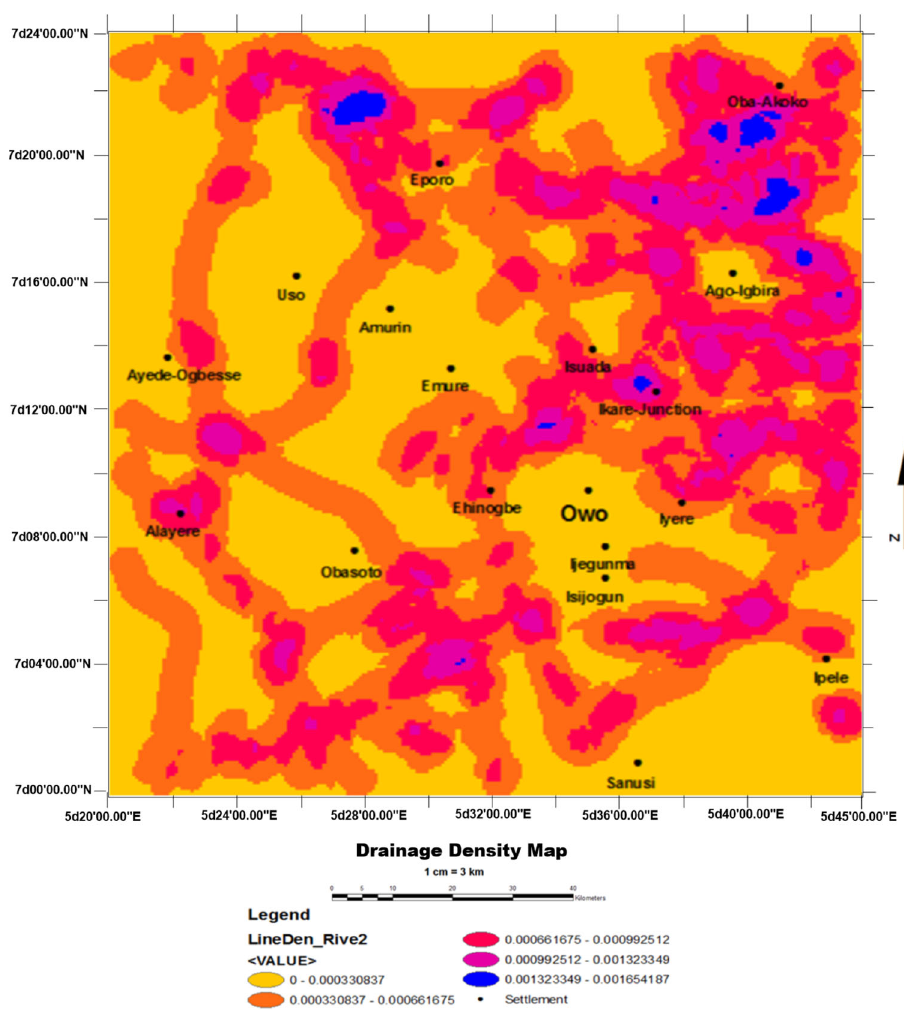
Fig. 6 Drainage density map of the